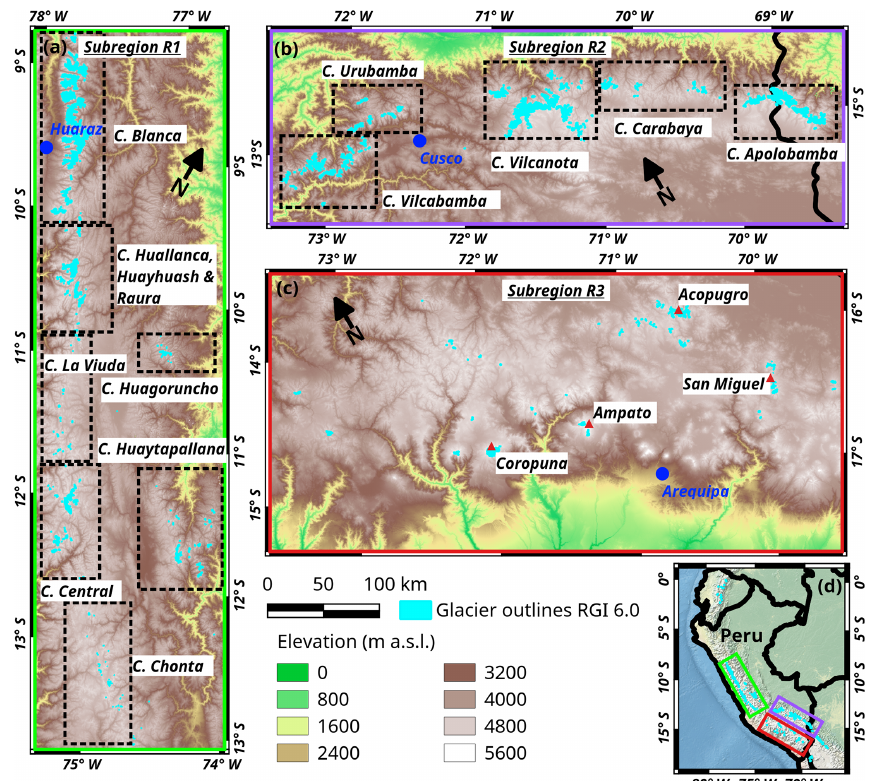
Figure 1. General maps of study region. Panels (a–c) : glacier subregions in Peru according to Sagredo and Lowell (2012); (a) subregion R1: northern wet outer tropics; (b) subregion R2: southern wet outer tropics; (c) subregion R3: dry outer tropics. Panel (d) : overview map of Peru. Coloured rectangles indicate the locations of the subregions (same frame colours). Light blue areas: glacier coverage based on RGI 6.0. Background: SRTM DEM ©